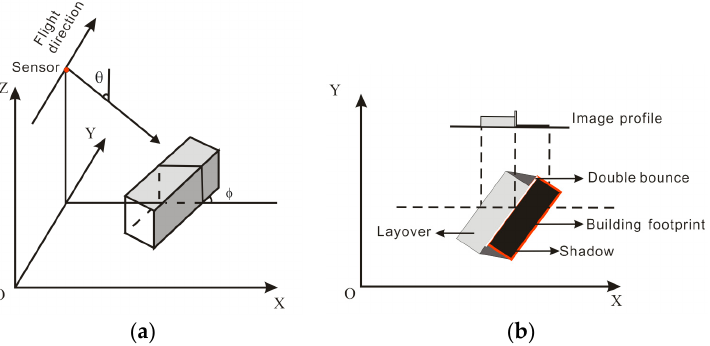
Figure 3. An illustration of SAR imaging of a flat roof building: ( a ) Relationship between the sensor and the building; ( b ) building in the image plane.